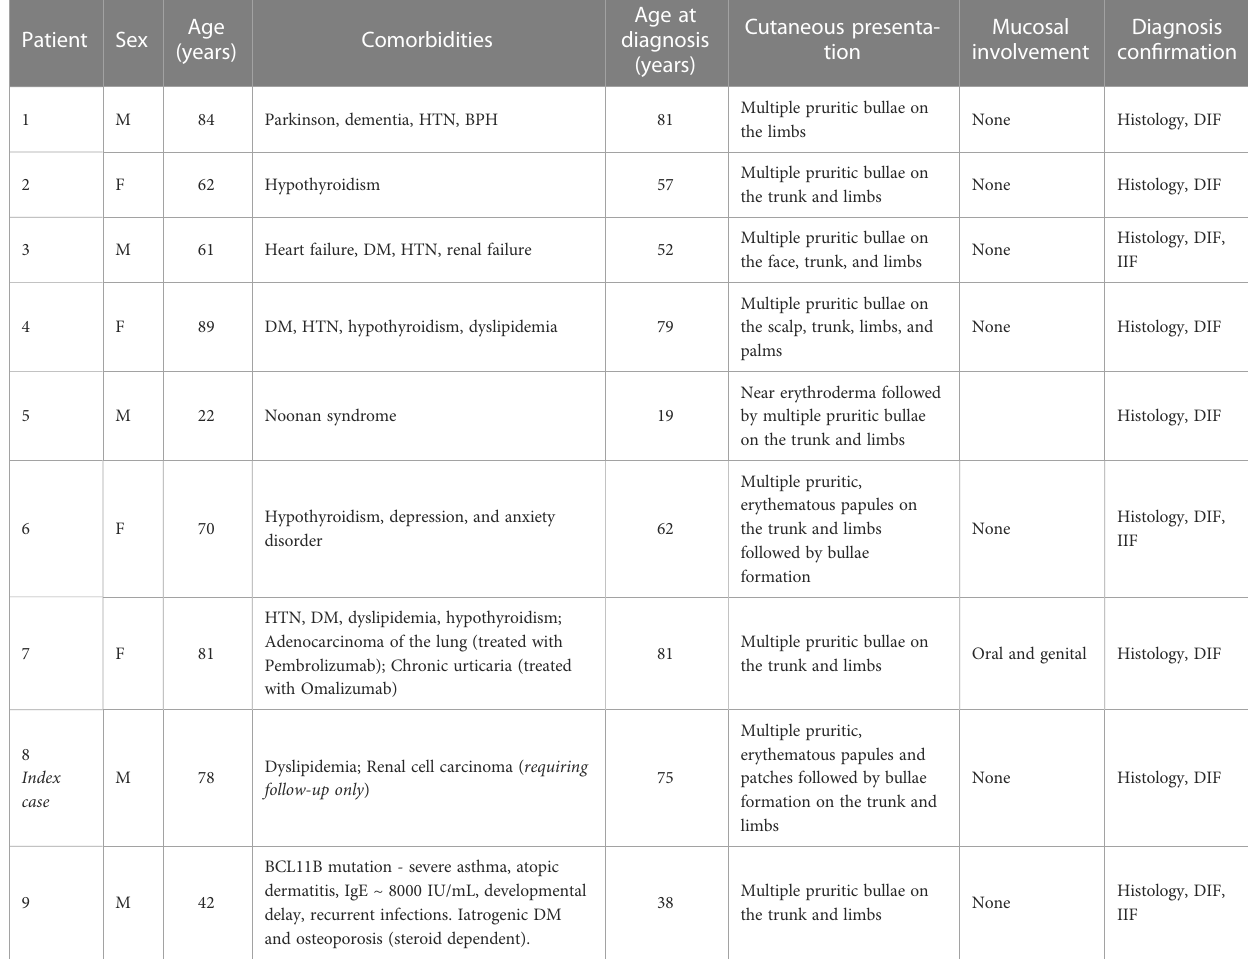
TABLE 1 Demographic, clinical, and immunopathological characteristics of patients.